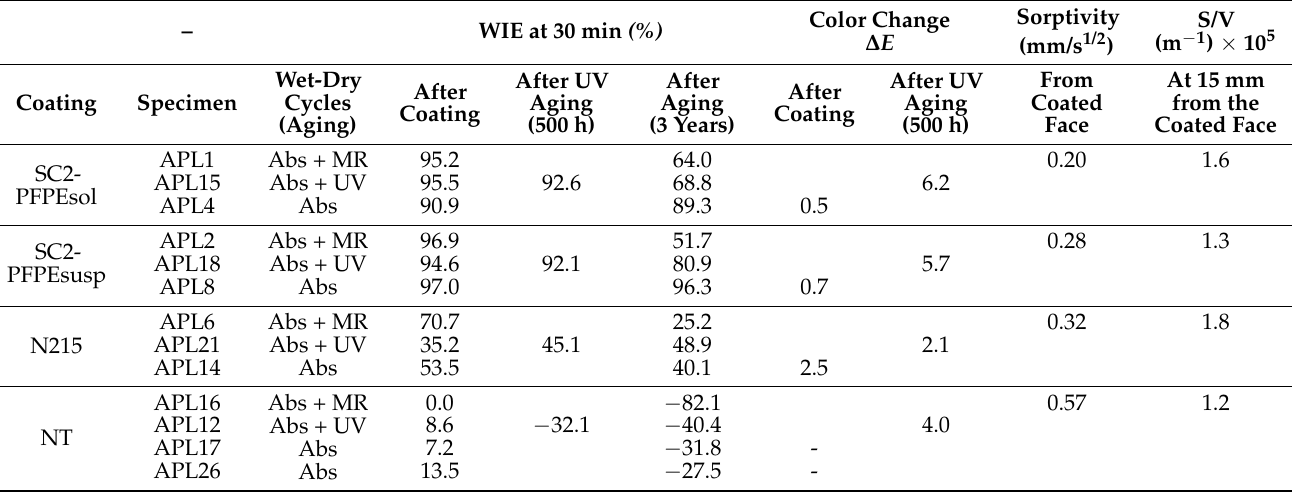
Table 6. Summary of the most important properties provided by SC2-PFPE and N215 coated Lecce stone specimens. Untreated specimens (NT) were used as a